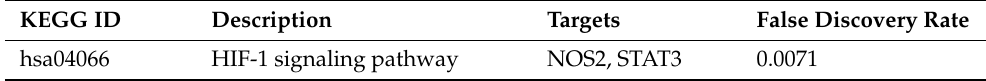
Table 4. Targets in one signaling pathway enrichment related to AMPs—AFPs—ACPs’ axis.